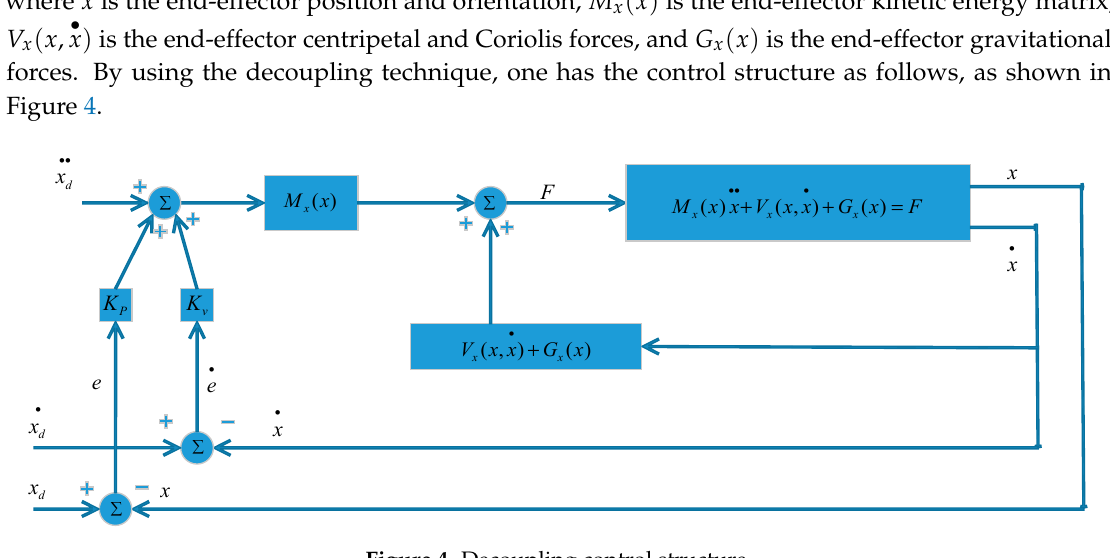
Figure 4. Decoupling control